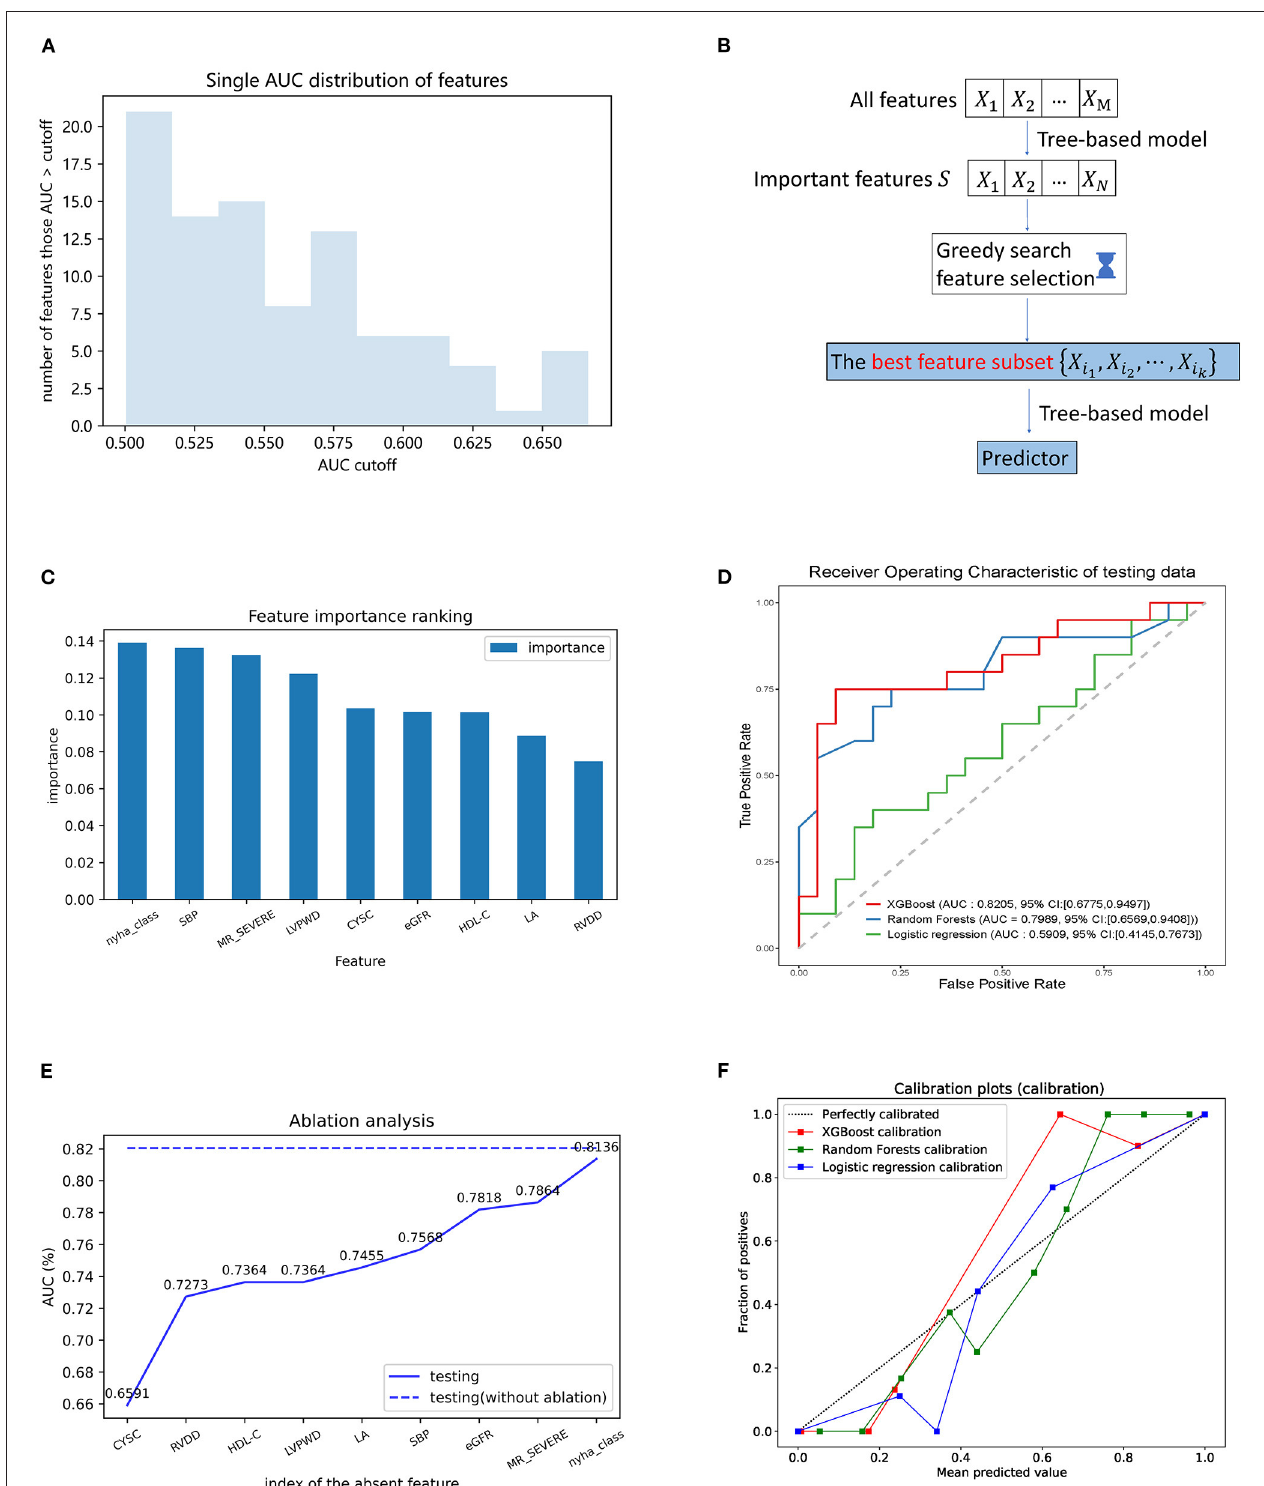
FIGURE 3 | Building model procedure and contributions of the selected features in the prediction. (A) AUC distribution obtained by individual features in the prediction of LVRR and non-LVRR; (B) flowchart of greedy feature selection by XGBoost; (C) greedy feature selection provides the nine best features and the comparison of their importance; (D) receiver operating characteristic curve of three models in testing set. Green, blue, and red curves were generated by the logistic regression, the